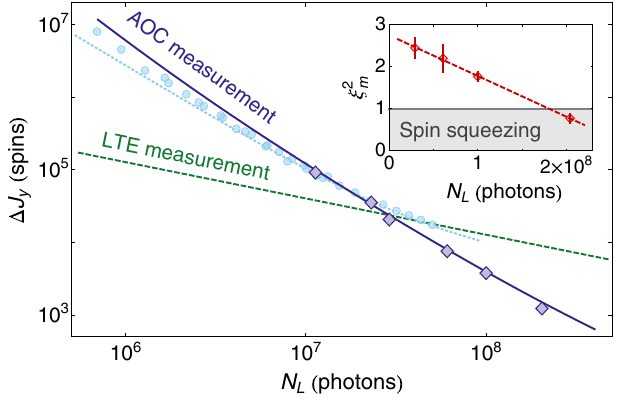
FIG. 3. Log-log plot of the uncertainty Δ J y of the AOC measurement versus number of photons N L . Blue diamonds indicate the measured sensitivity. Nonlinear enhanced scaling of the sensitivity is observed over more than an order of magnitude in N L . A fit to the data yields Δ J y ∝ N k L with k ¼ − 1 . 46 (cid:1) 0 . 04 . The best observed sensitivity is Δ J y ¼ 1290 (cid:1) 90 spins with ¼ 2 × 10 8 photons. For reference, we also plot the data (light N L blue circles) and theory (dotted curve) for the measurement of via nonlinear Faraday rotation reported by Napolitano et al. [8]. The solid blue curve represents theory given by Eq. (3) with no free parameters, plus the independently measured electronic noise contribution. The dashed green curve shows the theoretical prediction describing an ideal LTE measurement of J y without technical or electronic noise contributions. The nonlinear meas- urement sensitivity surpasses an ideal LTE measurement with N ¼ 3 × 10 7 photons. Error bars for standard errors would be L smaller than the symbols and are not shown. Inset: Observed metrologically significant spin squeezing ξ 2 m as a function of photon number. The dashed line is a guide to the eye. Error bars indicate (cid:1) 1 σ standard errors.